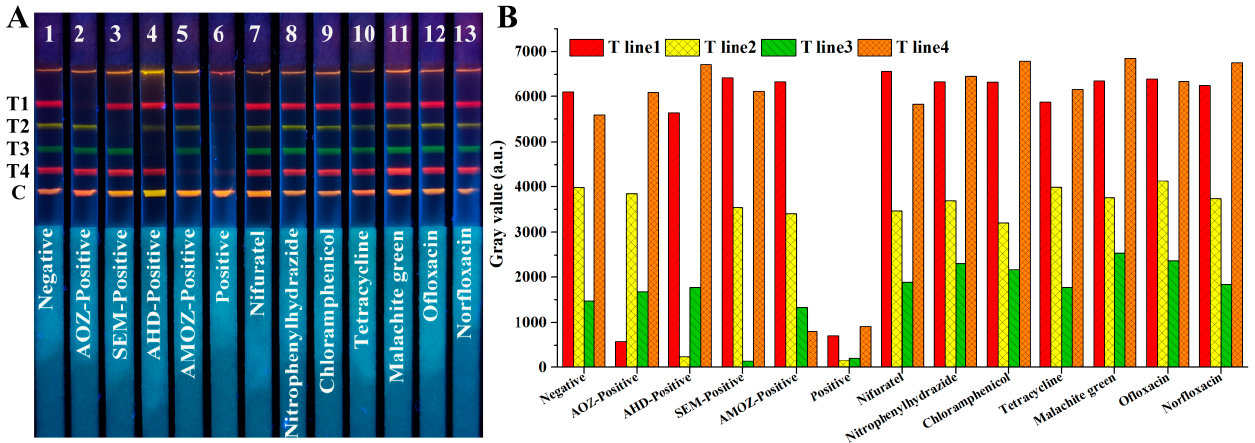
Figure 5. Cross-reaction and specificity analysis of our developed QB-based mICA strip, ( A ) fluo- rescent image of mICA strip under UV light, ( B ) gray values analysis of four T lines. T1, T2, T3, T4, and C lines were 2-NPAOZ-BSA, 2-NPAHD-BSA, 2-NPSEM-BSA, 2-NPAMOZ-BSA, and rabbit T4, and C lines were 2-NPAOZ-BSA, 2-NPAHD-BSA, 2-NPSEM-BSA, 2-NPAMOZ-BSA, and anti-mouse IgG, respectively.